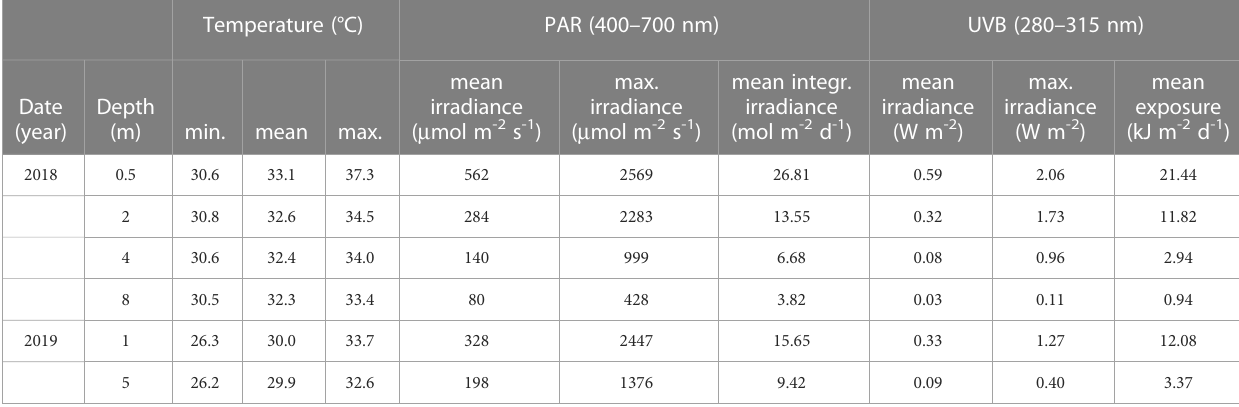
TABLE 2 Water temperature and solar radiation (PAR and UVB) in different depths at Al Fahal reef in the central Red Sea between 5 th July – 12 th August 2018, and during the Pocillopora verrucosa transplant experiment from 28 th April – 16 th June 2019.